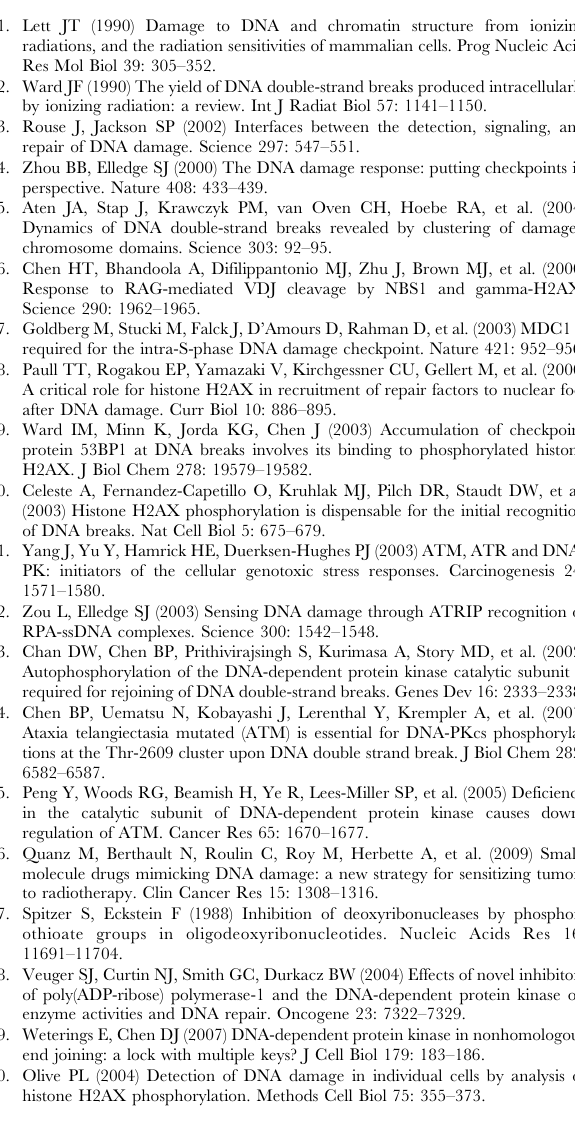
Figure S3 TUNEL assay and different transfection protocols. Found at: doi:10.1371/journal.pone.0006298.s003 (1.42 MB TIF) Figure S4 Persistent inhibition of IRIF formation in c -H2AX positive cells at 24 h after transfection. Found at: doi:10.1371/journal.pone.0006298.s004 (1.84 MB TIF) Figure S5 Cell cycle arrest of Dbait treated cells after